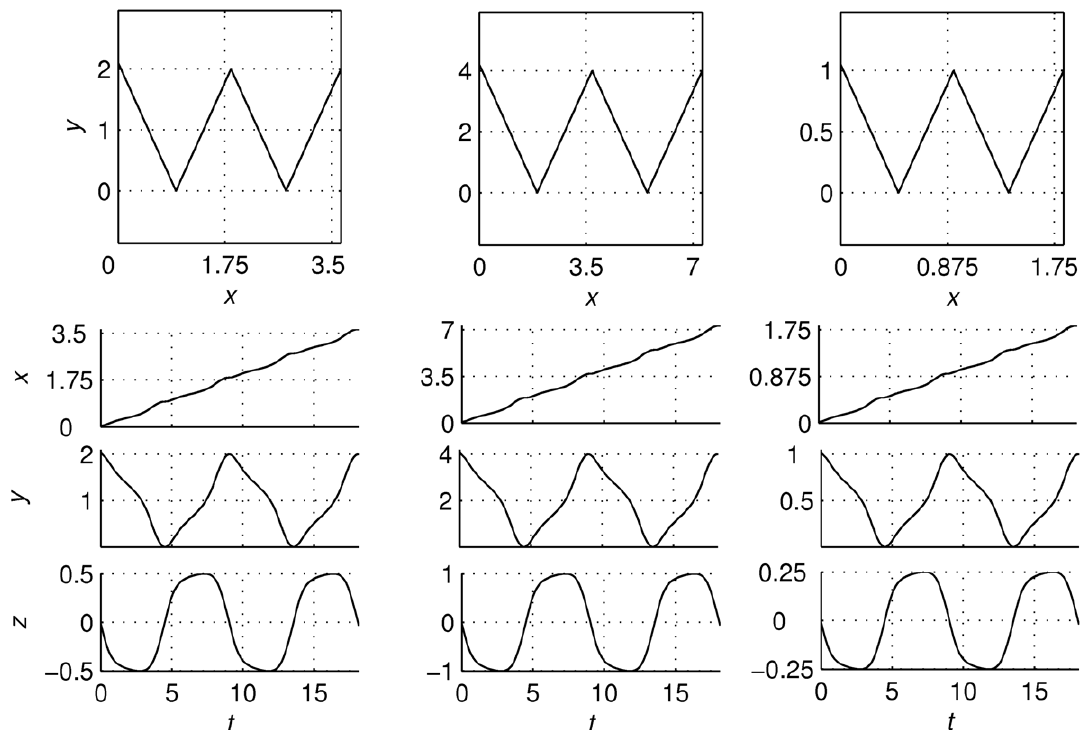
Figure 5. Phase flow scaling. The figure shows the architecture’s output generating the character ‘ w ’ with a different movement amplitude at each column: from left to right, the radius of the cylindrical manifold is the default one ( r =1), two times larger ( r =2) and its half ( r =0.5). From top to bottom: the architecture’s output in the handwriting workspace (the plane x - y ), and the state variables’ time series ( x , y , and z ). The duration as well as the profile of each stroke’s time series is almost identical for all values of the movement amplitude (the isochrony